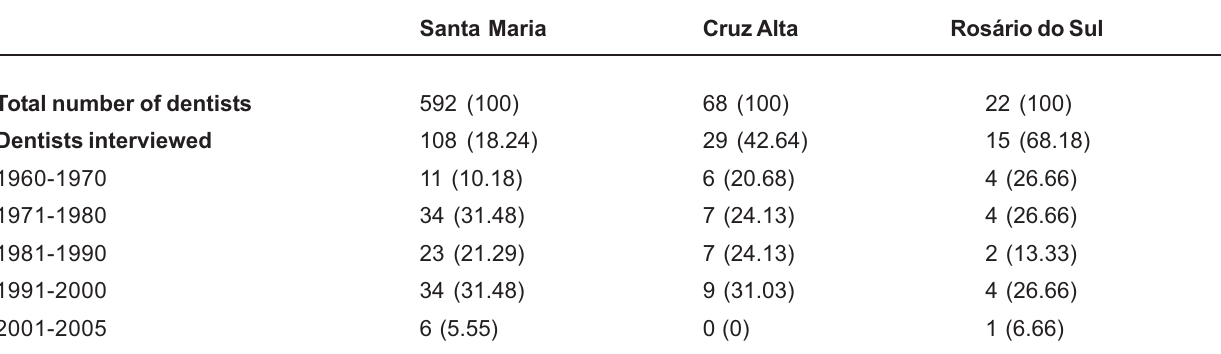
TABLE 1- Number and percentage (n(%)) of dentists interviewed in the